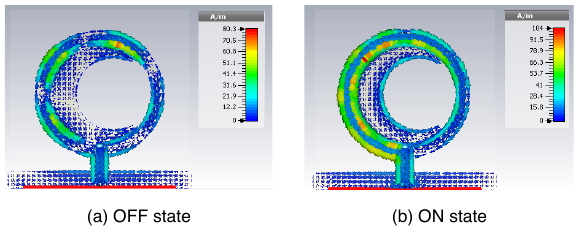
FIGURE 4. Current distribution on the radiating patch